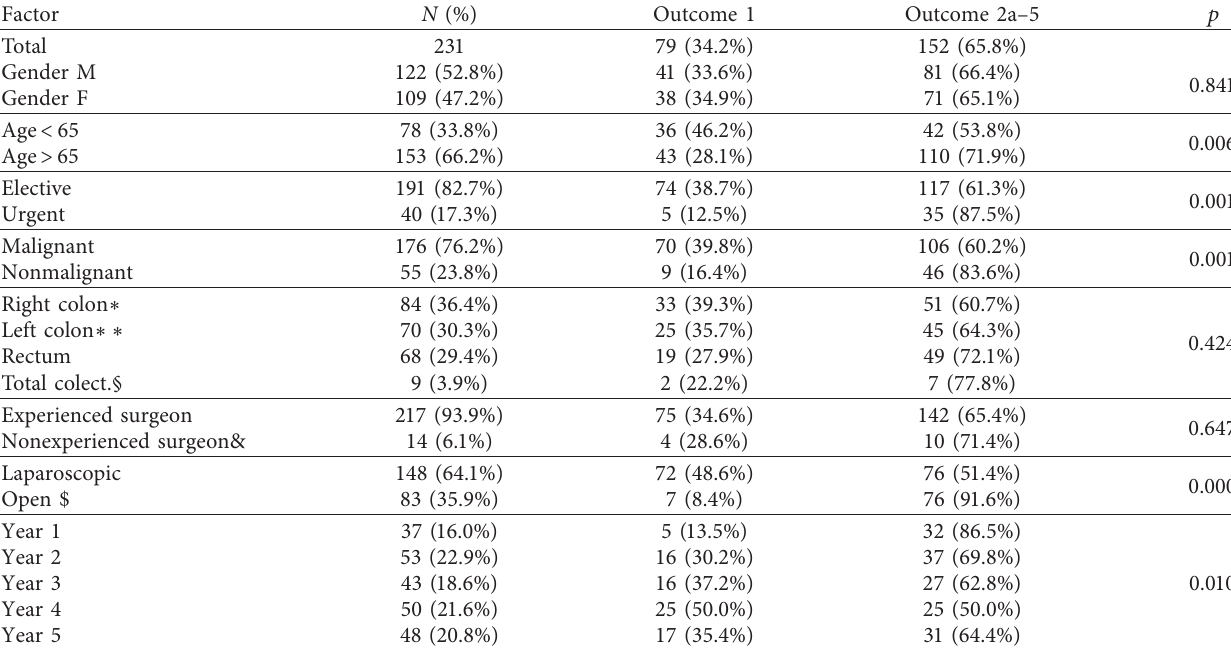
Table 2: Univariable analysis.